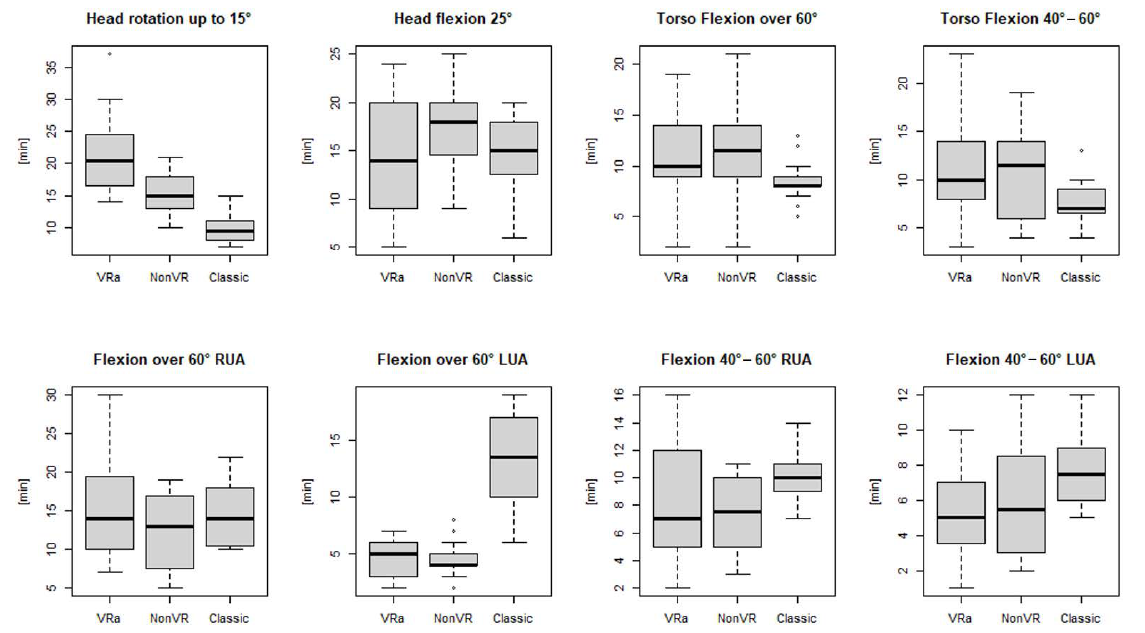
Figure 11. Wilcoxon Pair Test—Box-plot